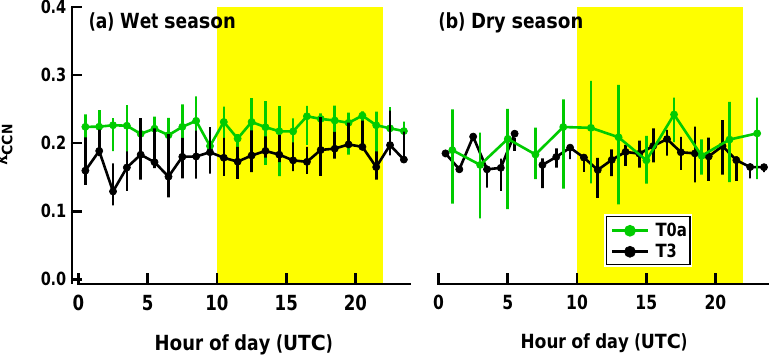
Figure 8. Comparison κ CCN values derived from measurements at the T0a (ATTO) site (Pöhlker et al., 2016) and at the T3 site under background conditions (this study) during the (a) wet season (April and May 2014) and (b) dry season. The size-resolved CCN data at T0a was collected by stepping the particle size at given CCNC supersaturations (Rose et al., 2008). Data displayed for T0a are averaged over critical particle diameters ranging from 44 to 175nm, while the T3 data are averaged from measurements at 112, 142, and 171nm.